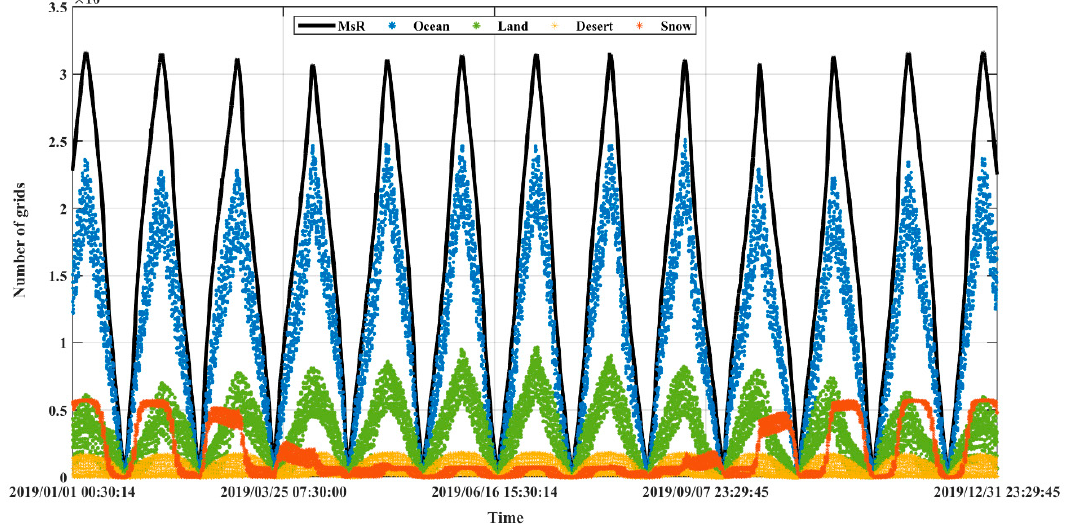
Figure 8. Number of grids of four scene types, ocean, land, desert, and snow, in the Moon-based sunlit region (MsR).